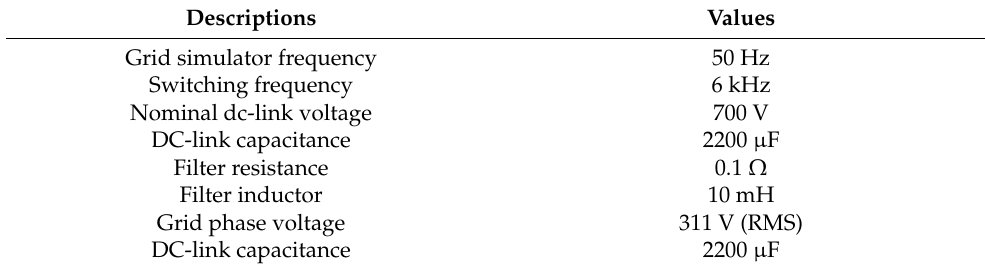
Table 1. Experimental system parameters.